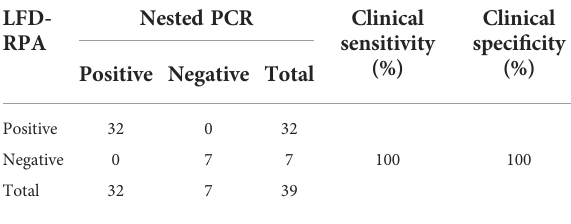
TABLE 2 The detection results of the clinical samples by the nested PCR and LFD-RPA (Jaroenram & Owens, 2014). LFD- Nested PCR Clinical RPA